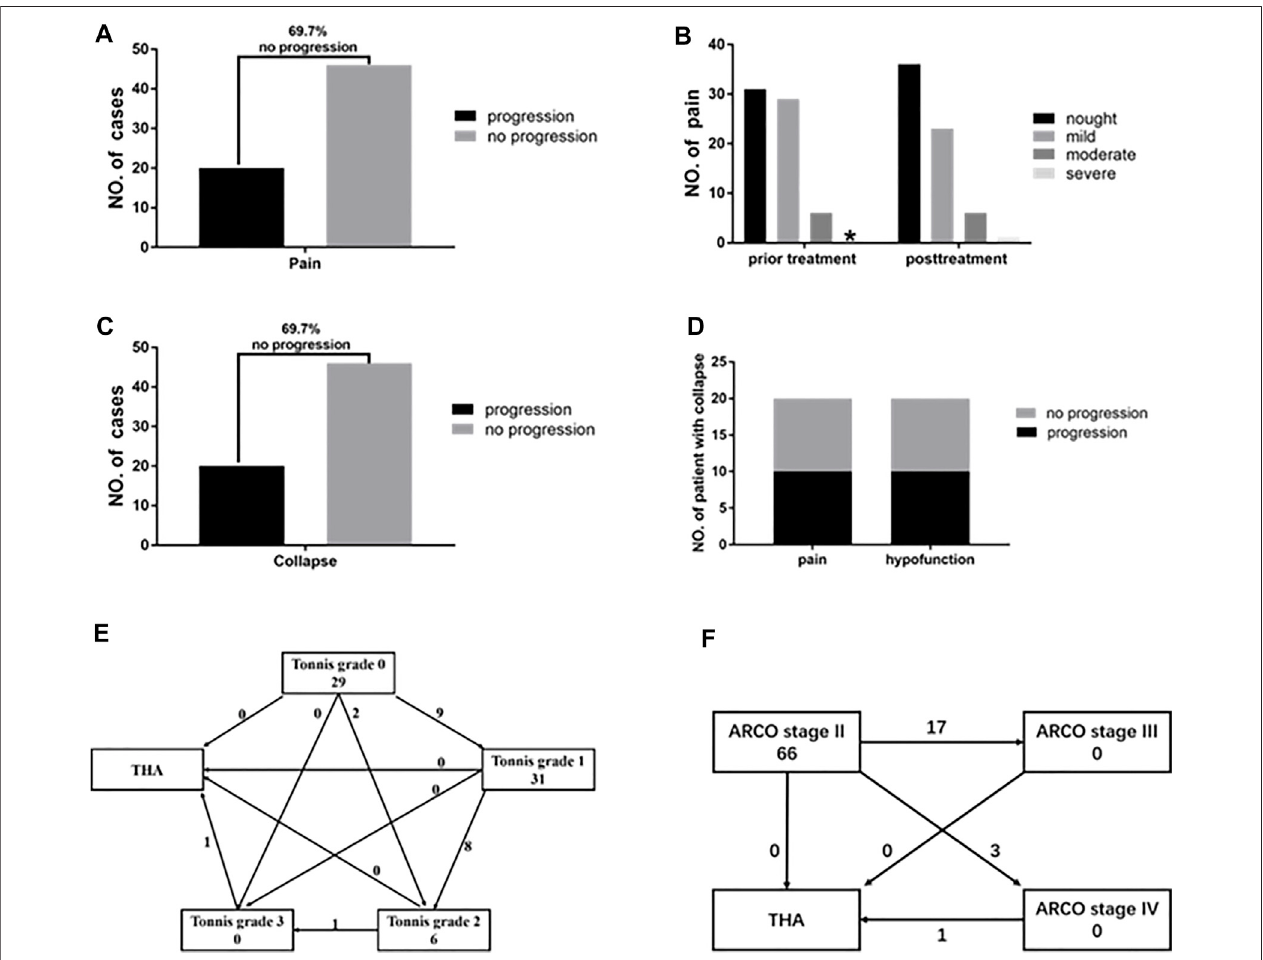
FIGURE5| ARCOstageIIONFHpatientsafteraverage7.95yearsoffollow-up. (A) AftertakingHXTLcapsuletherewere69.7%ofpatientsshowednoprogressin pain. (B) The degree of pain before and after taking HXTL capsule exhibited no signi fi cant difference. Nought means VAS is 0, mild means VAS from 1 to 3, moderate means VAS from 4 to 6, and severe means VAS from 7 to 10.* means the number is 0. (C) After taking the HXTL capsule, there were 69.7% of patients that showed no progress incollapse. (D) Among the 20femoralheads thatcollapsed, 10of them had no progression inpain and hypofunction (50%), and 10ofthem experienced pain progression and hip dysfunction (50%). (E) Changes in Tonnis classi fi cation before and after treatment. (F) Changes in the ARCO stage of the patients after treatment.